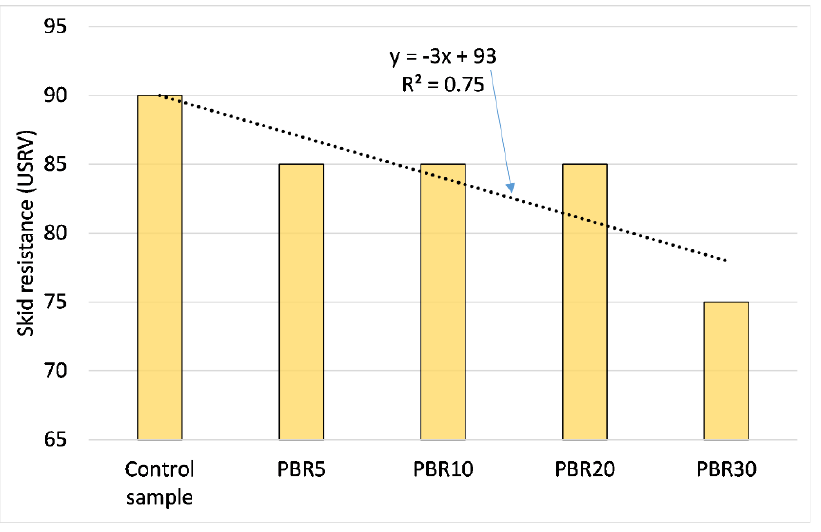
Figure 11. Skid resistance of CR IPB at 28 days.